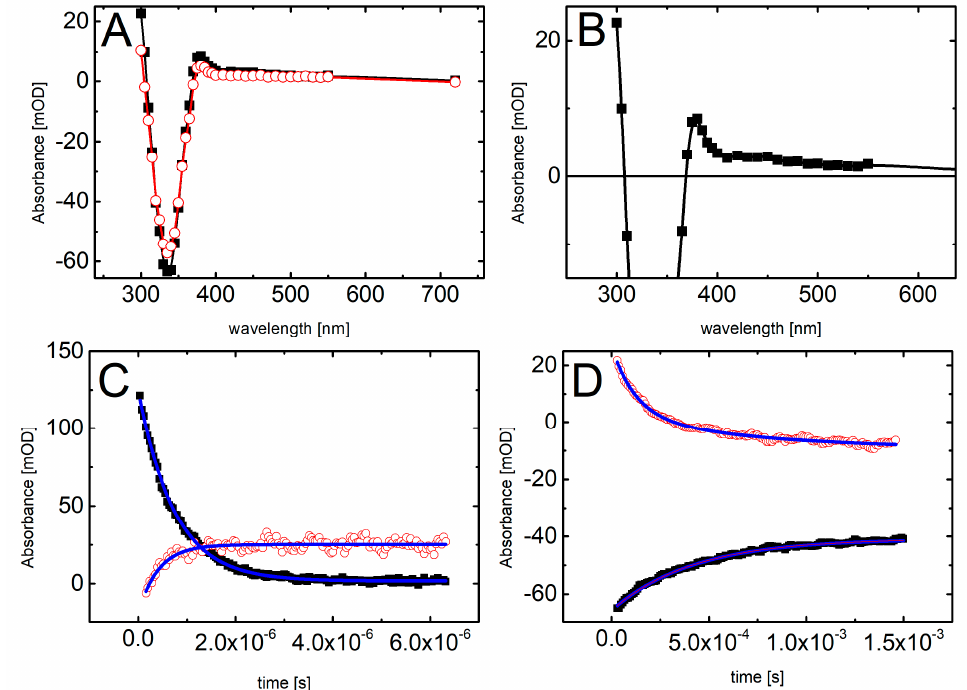
Figure 5. Transient absorption spectra recorded in deoxygenated and buffered with phosphate (10 mM, pH = 7.0) BrSdU solution (5 · 10 − 5 M), in the presence of 0.5 M t -BuOH ( A ) after 12 μ s ( ■ ) and 120